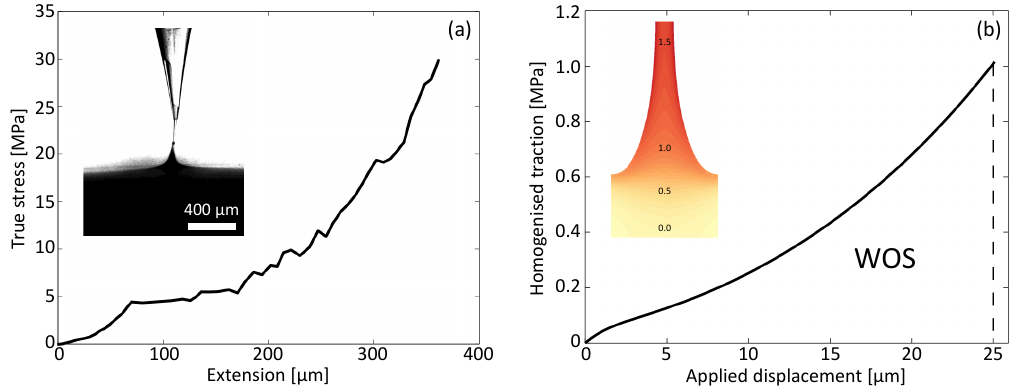
Figure 5. ( a ) the PDMS single fibril experiment: example of a measured maximum true stress–extension curve during stretching, the inset shows drawing of the material from the hollow tip into the fibril, while simultaneously stretching the fibril, just before fibril rupture; ( b ) homogenised traction–separation response obtained from the single fibril micro-model, the inset shows the final stage of the simulated fibrillation process in which colours indicate the maximum principal true strain as indicated by the